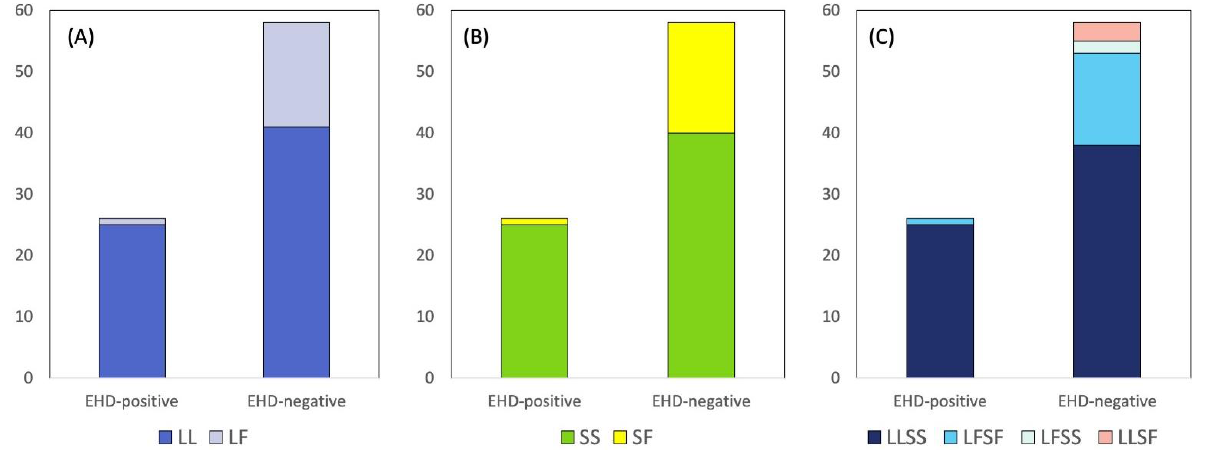
Figure 3. Association of SNPs in TLR3 with epizootic hemorrhagic disease (EHD) in Illinois white- tailed deer ( n = 84). ( A ) When both copies of the TLR3 gene in an individual deer encoded L at codon 59, the deer were designated “LL”. When one copy encoded L and the other F, the deer were designated “LF”. In EHD-positive deer, LL was detected more frequently than LF relative to their frequencies in EHD-negative deer ( OR = 10.16, p = 0.0088, Fisher’s exact test, two-tailed). ( B ) When both copies of the TLR3 gene in an individual deer encoded S at codon 116, the deer were designated “SS”, whereas, when one copy encoded S and the other F, the deer were designated “SF”. In EHD-positive deer, SS was detected more frequently than SF relative to their frequencies in EHD-negative deer ( OR = 11.02, p = 0.0048, Fisher’s exact test, two-tailed). ( C ) In the last panel, deer were designated using four letters, with the first two letters indicating the amino acids encoded by codon 59, and the last two letters indicating the amino acids encoded by codon 116. For example, deer in which both copies of TLR3 encoded L at codon 59 and both copies encoded S at codon 116 were designated “LLSS”. The combination LLSS was detected relatively more frequently than LFSF in EHD-positive deer compared to EHD-negative deer ( OR = 9.67, p = 0.0151, Fisher’s exact test, two-tailed). The absence of FF deer for codon 59 ( A ) or FF deer for codon 116 ( B ) was likely due to the low frequencies of 59F and 116F, respectively, in the population. The low frequencies of LFSS and LLSF deer ( C ) were likely due to linkage disequilibrium between the two codons ( D = 0.083, p < 0.0001).